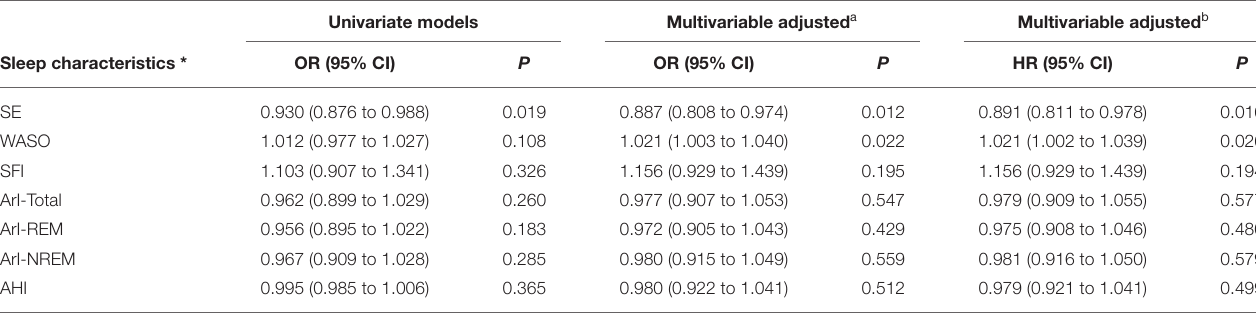
TABLE 2 | ORs and 95% CIs for sleep characteristics associated with depression.